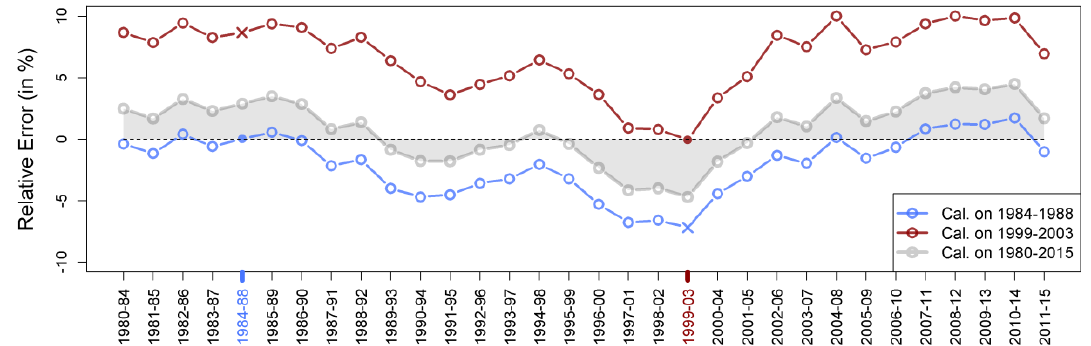
Figure 2. Moving bias curves of a hydrological model on the Steir river at Guengat (J4313010; in France) for three different calibration periods. The filled dot of the blue (respectively, red) curves indicates the 1984–1988 (respectively, 1999–2003) calibration period of the model. The crosses indicate the evaluation bias for 1999–2003 of the 1984–1988 calibration and the evaluation bias for 1984–1988 of the 1999–2003 calibration. The grey moving bias curve is obtained by calibrating the model on the total period. The grey area corresponds to a proxy for model robustness, as suggested in Sect.